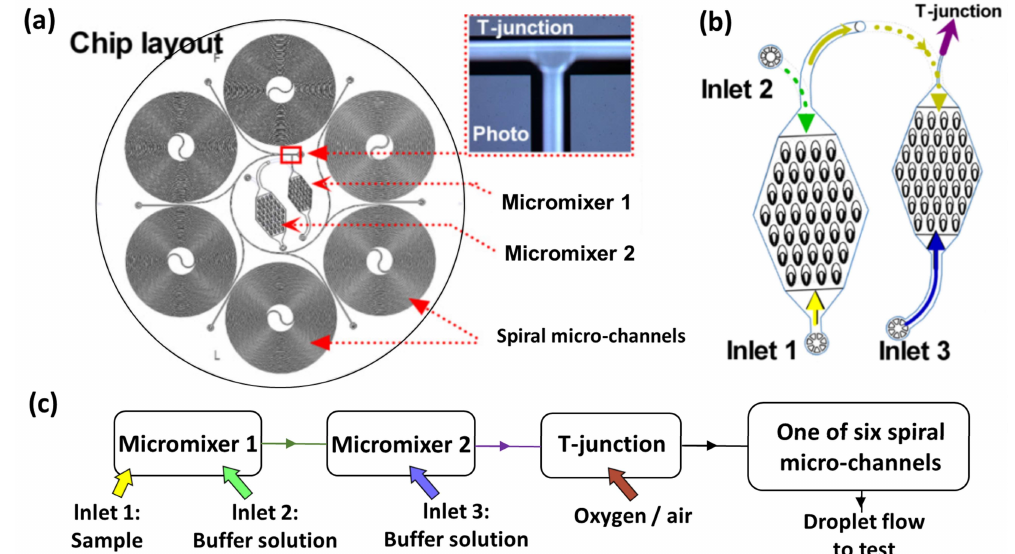
Figure 3. The bioluminescent cell-based optofluidic device for toxicant detection in water environment. V. fischeri is used as the toxicity indicator based on inhibition of luminescence; the device is designed to work continuously and shows high potential for home usage. ( a ) The optofluidic chip is composed of two counter-flow micromixers, a T-junction droplet generator, and six spiral microchannels; ( b ) two counter-flow micromixers and the flowing direction and mixing process; ( c ) the function of the different microstructures on the optofluidic chip